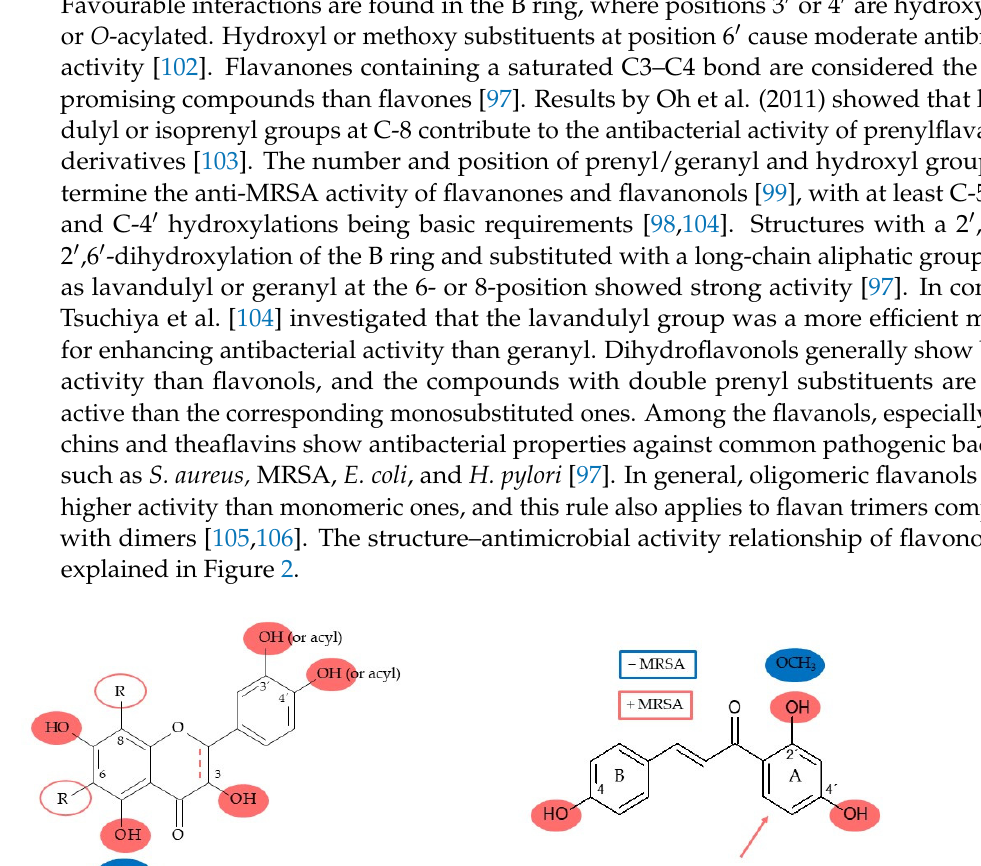
Table 1. Antibacterial activity of known prenylated flavonoids from natural sources.